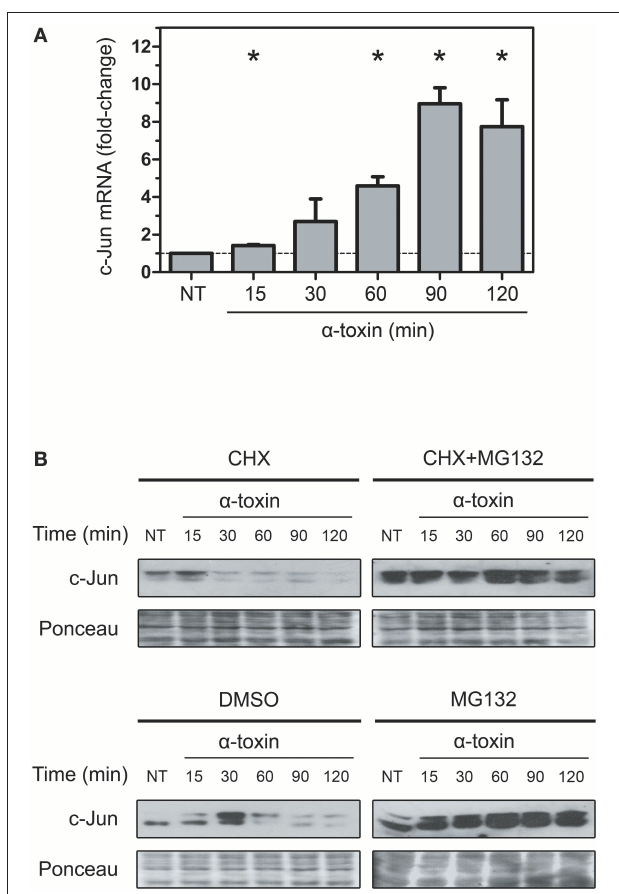
FIGURE 3 | Effect of α -toxin on the expression and stability of c-Jun. (A) Total mRNA was extracted from A549 cells which had been treated with α -toxin (5 µ g ml-1) for 15 to 120min or left untreated (NT). Subsequently, the amounts of c-Jun transcripts were determined by Quantitative real time PCR. Measurements were carried out in triplicate for three independent experiments, and the results are expressed as means with their SEM. Statistically significant differences at P < 0.05 are identified by * (Kruskal-Wallis followed by Dunn’s multiple comparison test). (B) A549 cells were treated with the translational inhibitor cycloheximide (CHX, 1 µ g ml-1), the proteasome pharmacological inhibitor MG132 (40 µ M) or, the combination of both for 30min, with the carrier DMSO being used for control experiments. Subsequently, cells were exposed to α -toxin (5 µ g ml-1) for 15 to 120min or left untreated (NT). Western Blots were performed with specific antibodies against c-Jun. Ponceau staining of total transferred proteins were used as loading controls. The panels illustrate typical blots obtained from 4 independent